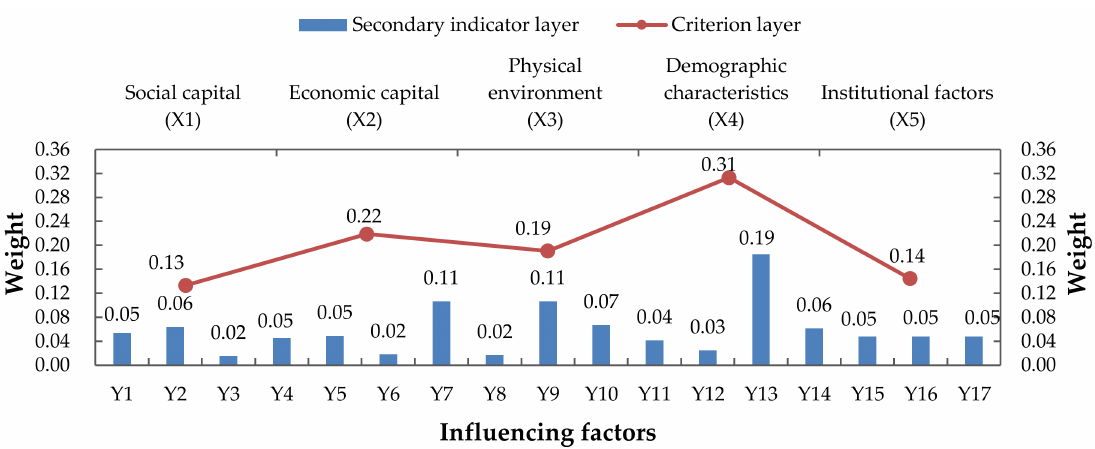
Figure 5. The total weight of factors of urban community